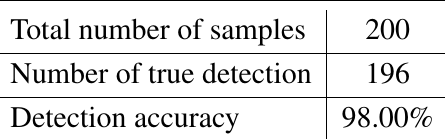
Table 3. Overview result of detection.